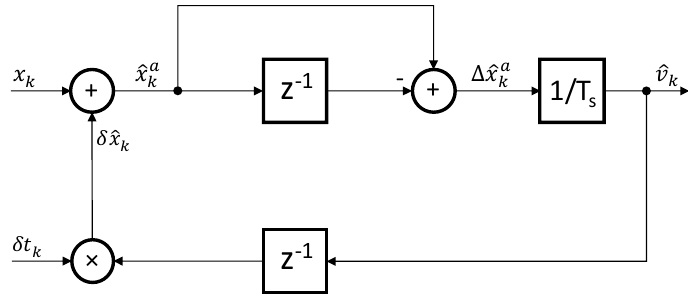
Figure 4. The block scheme of the MT-type division-less algorithm [52].